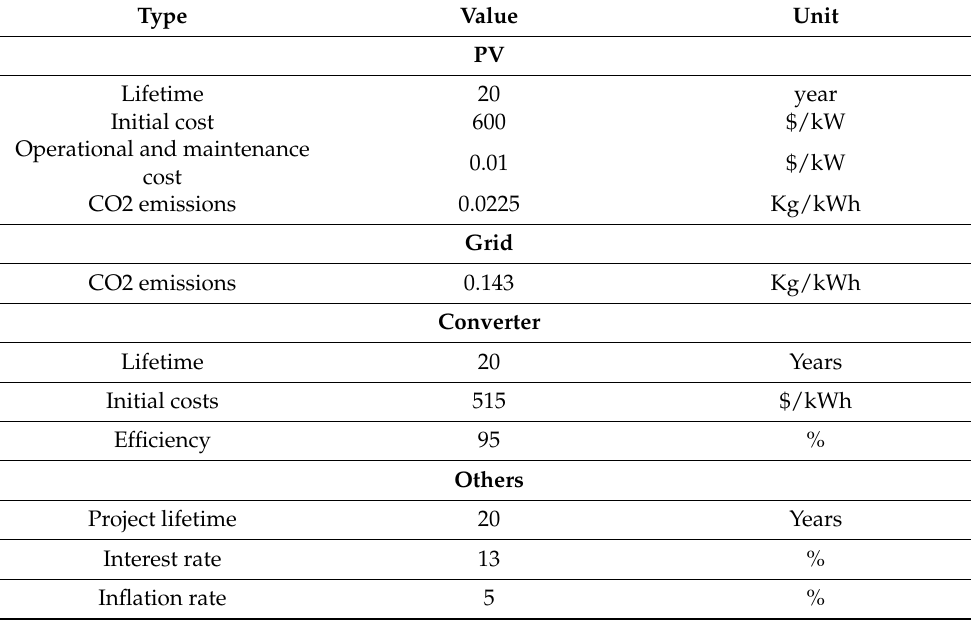
Table A1. Technical and economic parameters of system components according to Abo-Elyousr and Elnozahy [34].